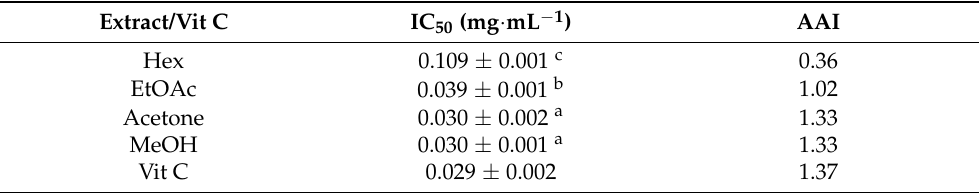
Table 3. Radical-scavenging activity (DPPH) assay of Erodium arborescens aerial part extracts compared to Vitamin C as